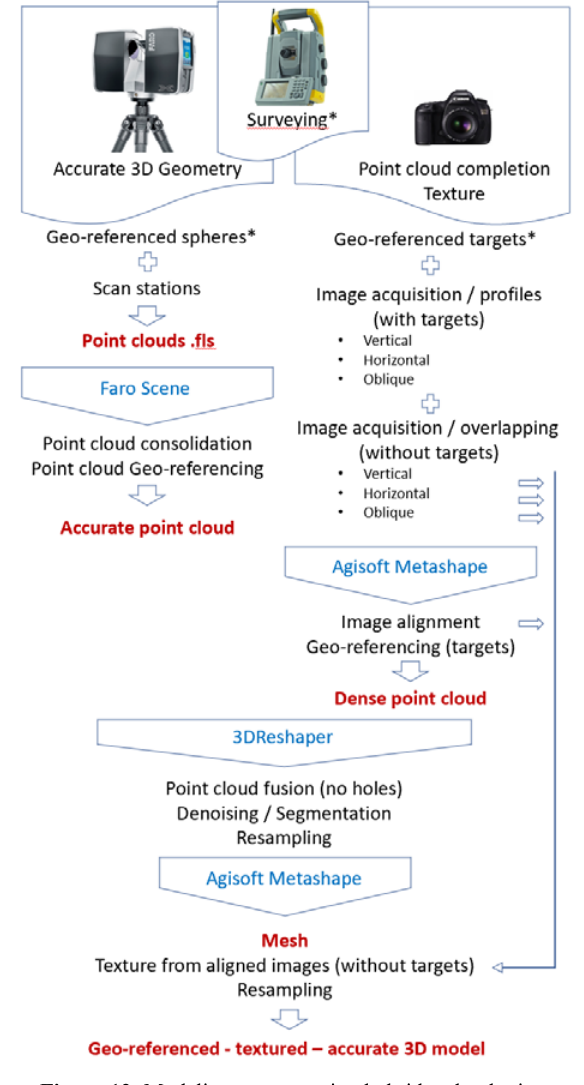
Figure 12 : Modeling process using hybrid